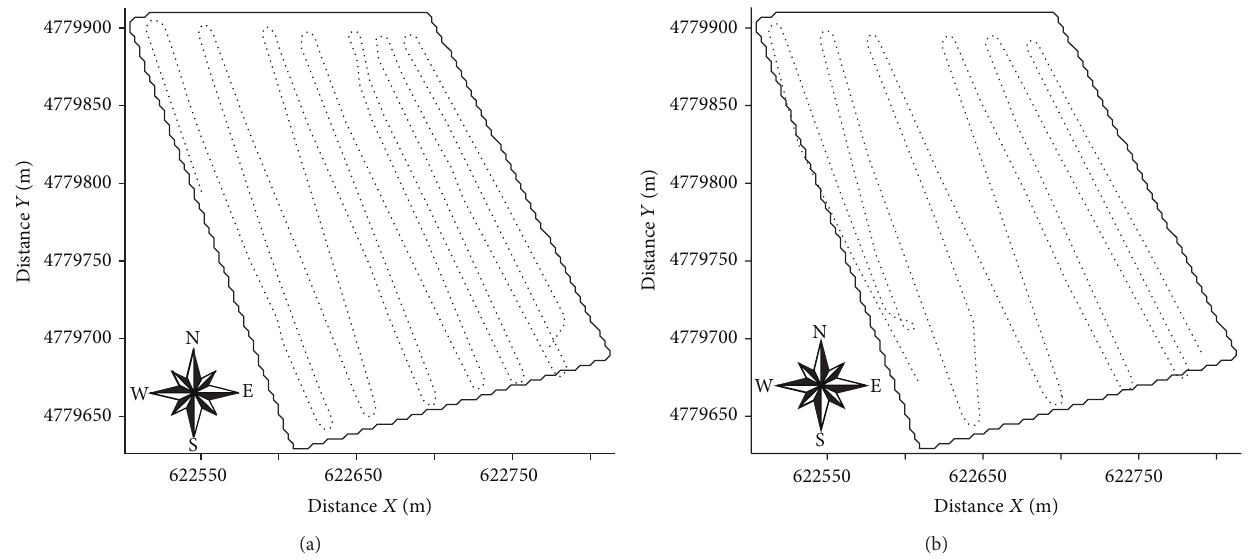
Figure 3: Scheme showing apparent electrical conductivity (EC